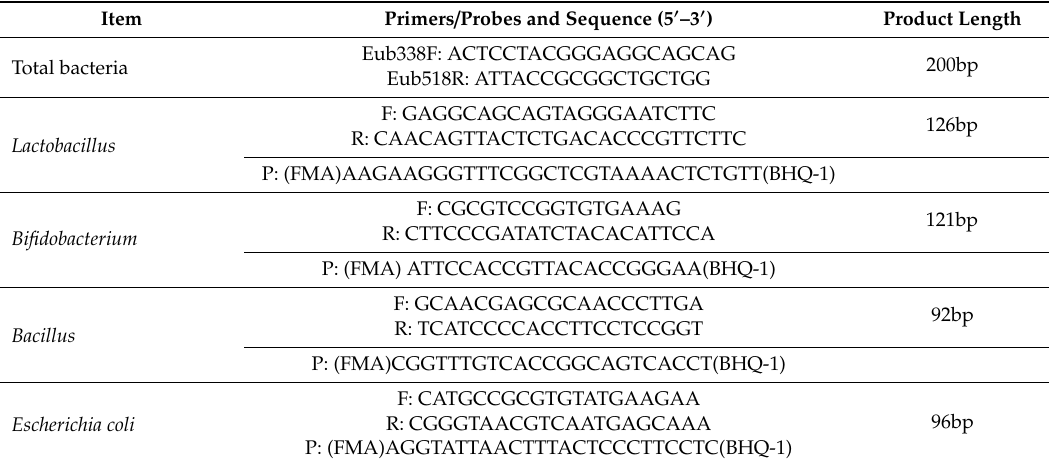
Table 4. Primers / probes for real-time PCR of